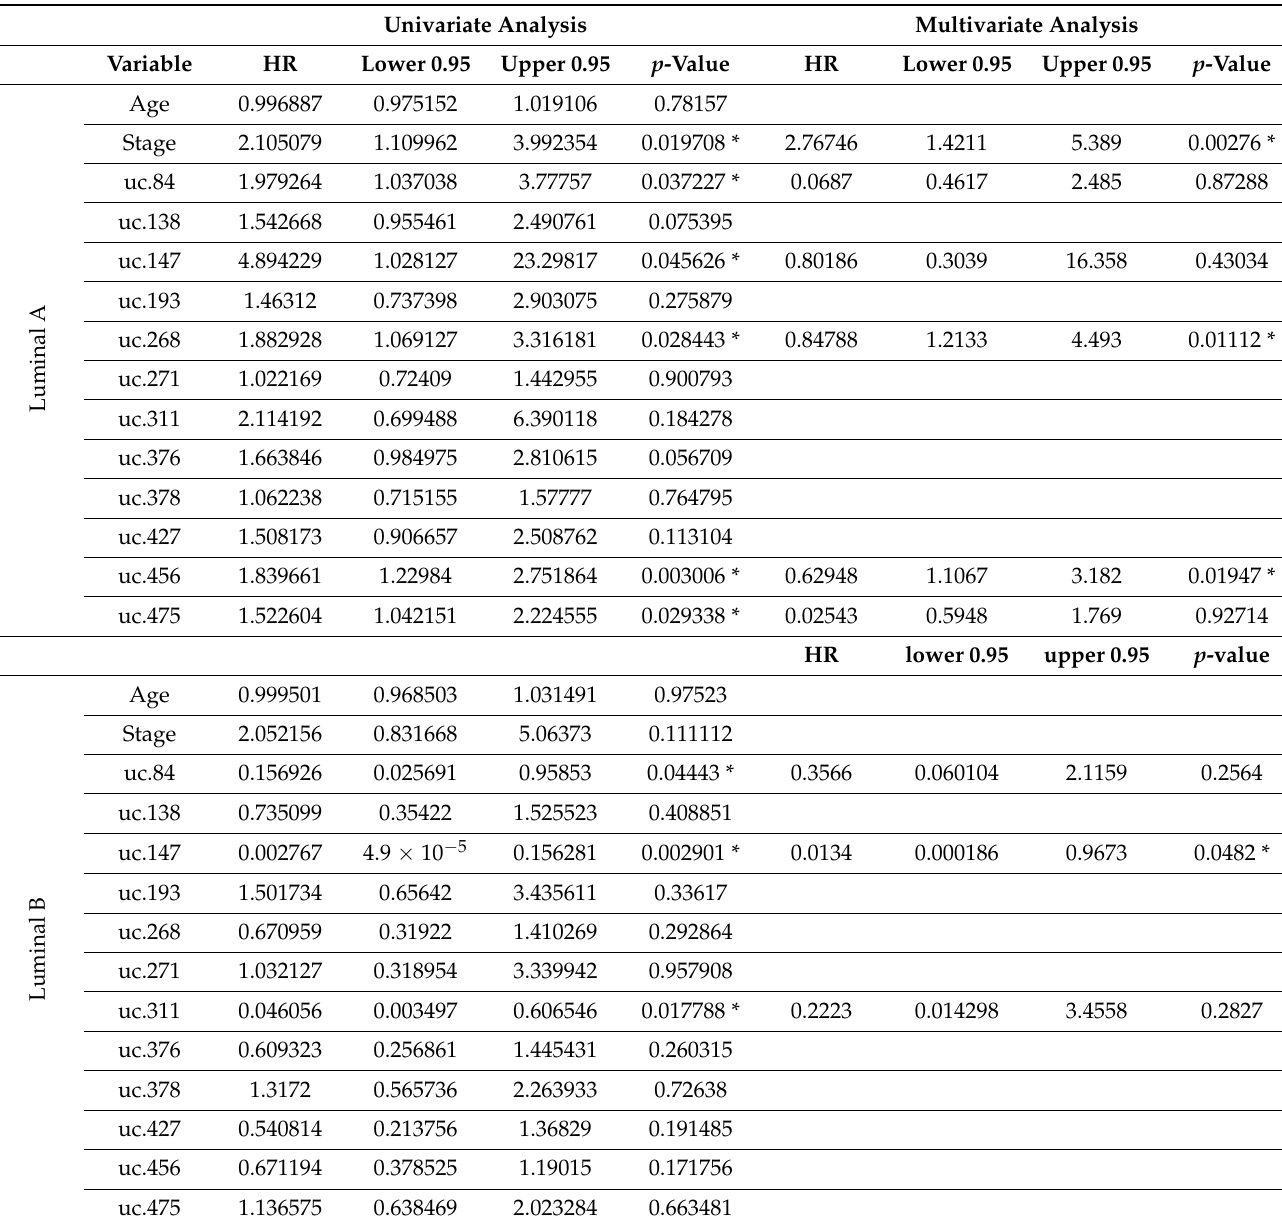
Table 5. Summary of univariate and multivariate Cox regression analysis of T-UCRs in Progression Free Interval among